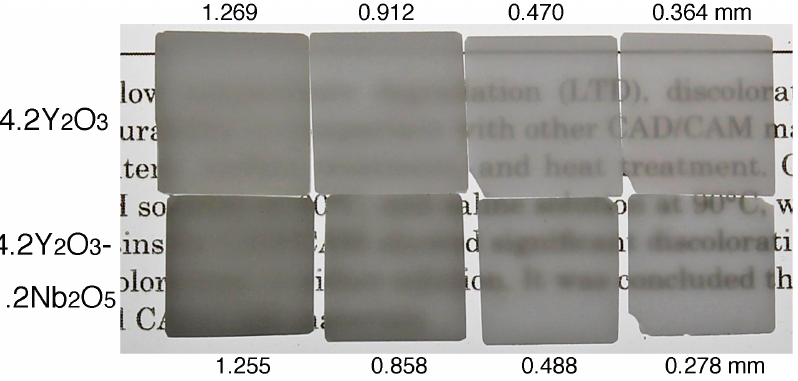
Figure 9. Photograph in transmission light of ZrO 2 -4.2 mol% Y 2 O 3 with and without 1.2 mol% Nb 2 O 5 (No. 16 and 3) having 0.278–1.255 and 0.364–1.269 mm in thickness, respectively.